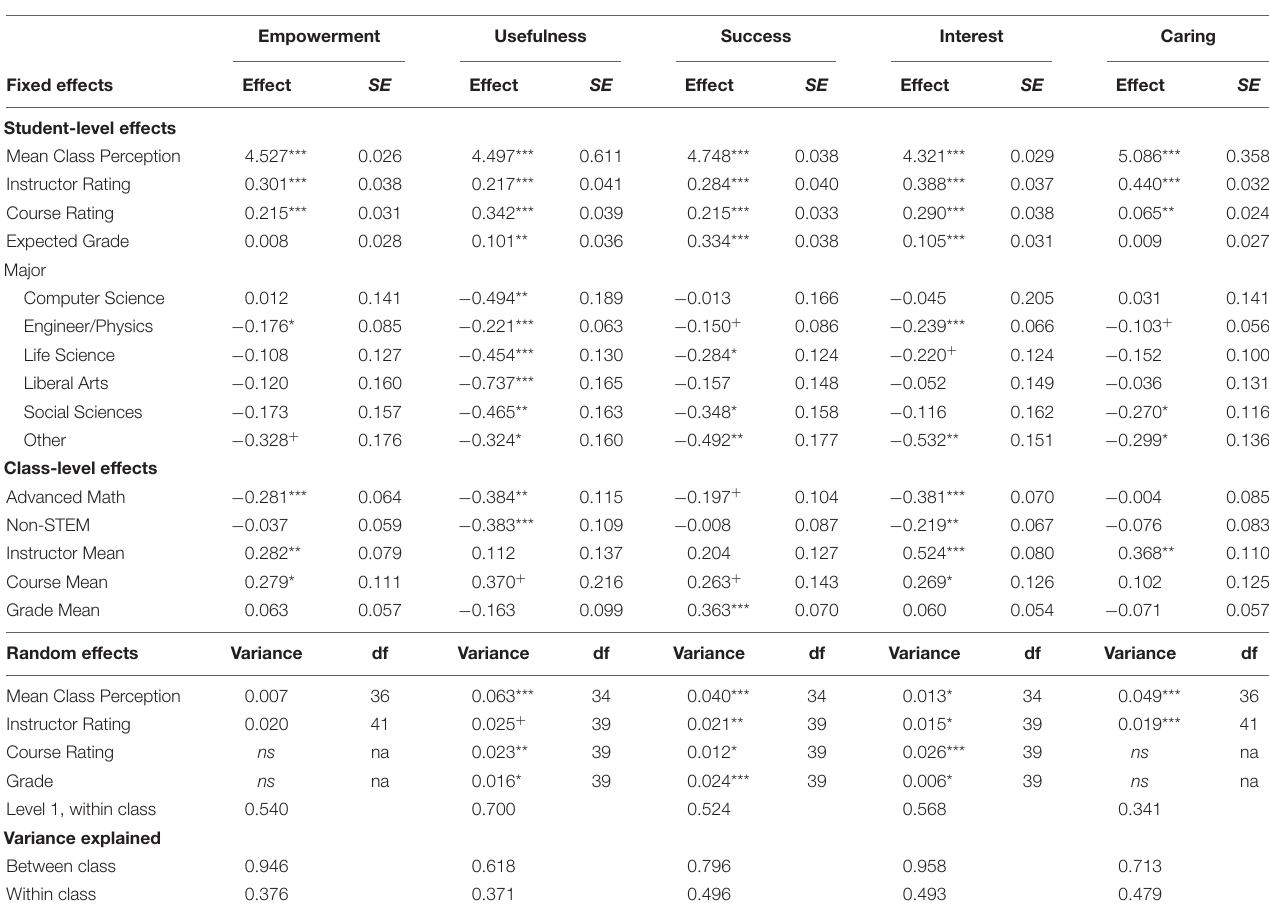
TABLE 6 | Final models for the five components of the MUSIC model of